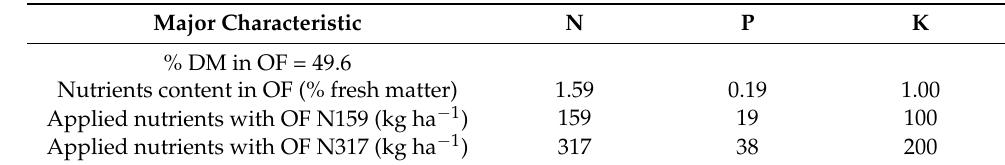
Table 1. Nutrient content of fermented F. japonica (OF) (% in fresh matter) and major nutrients application.